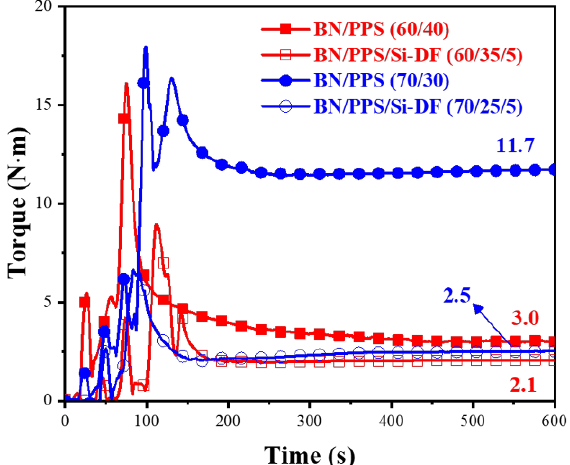
Figure 7. Torque versus time of BN/PPS